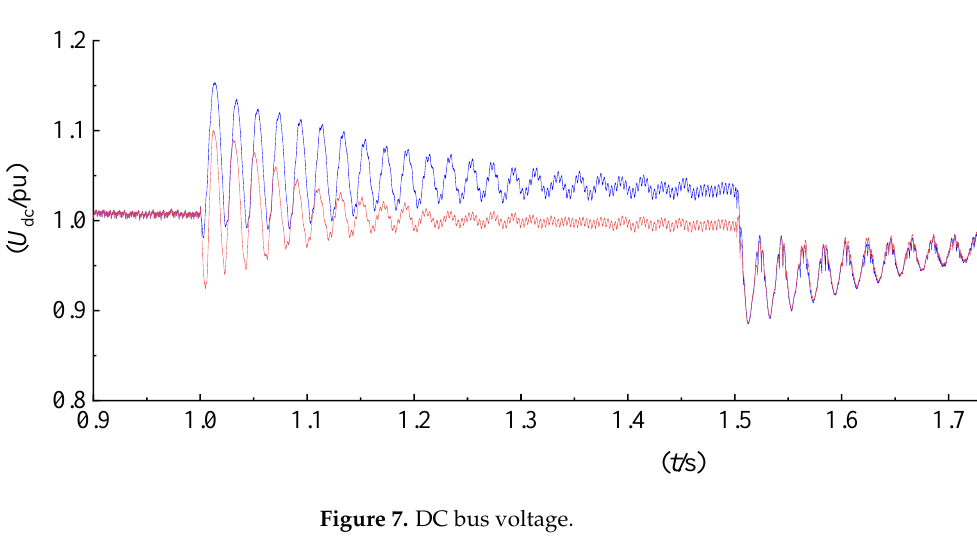
Figure 7. DC bus voltage.